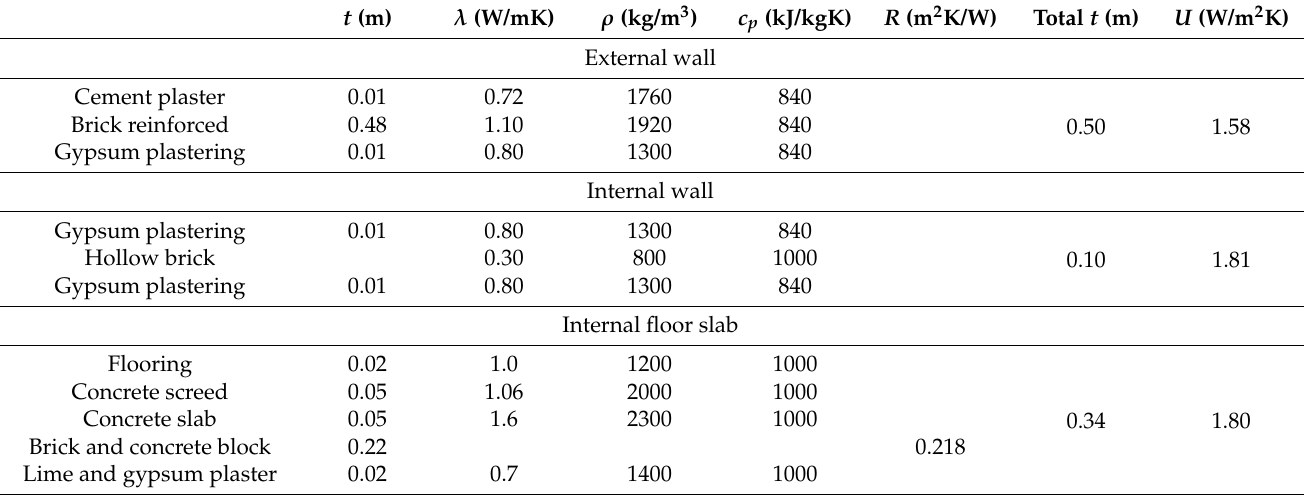
Figure 3. View from top of the hospital ( a ); view of analyzed rooms ( b ); HVAC units/ventilation ducts distribution in the rooms ( c ). Table 2. Thermo-physical characteristics of opaque building